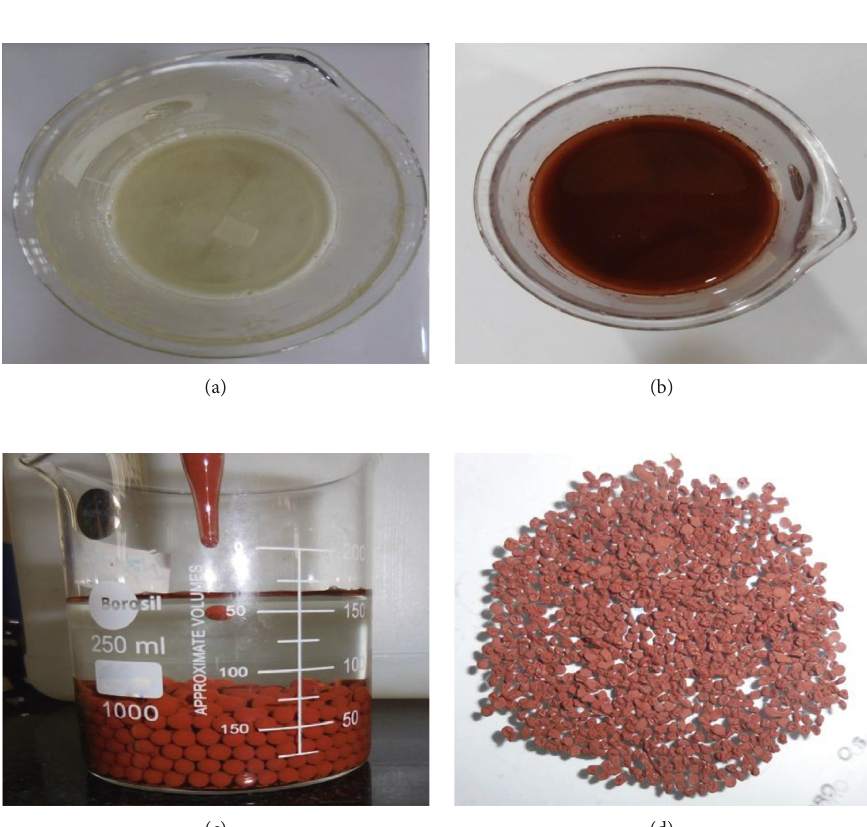
Figure 1: Hydrazine sulphate-treated calcium alginate beads. (a) 3.0% sodium alginate solution. (b) Treated red mud and sodium alginate mixture. (c) Formation of Ca-alginate beads doped with treated red mud. (d) Dried adsorbent (HRMCAB) at 343 K used for